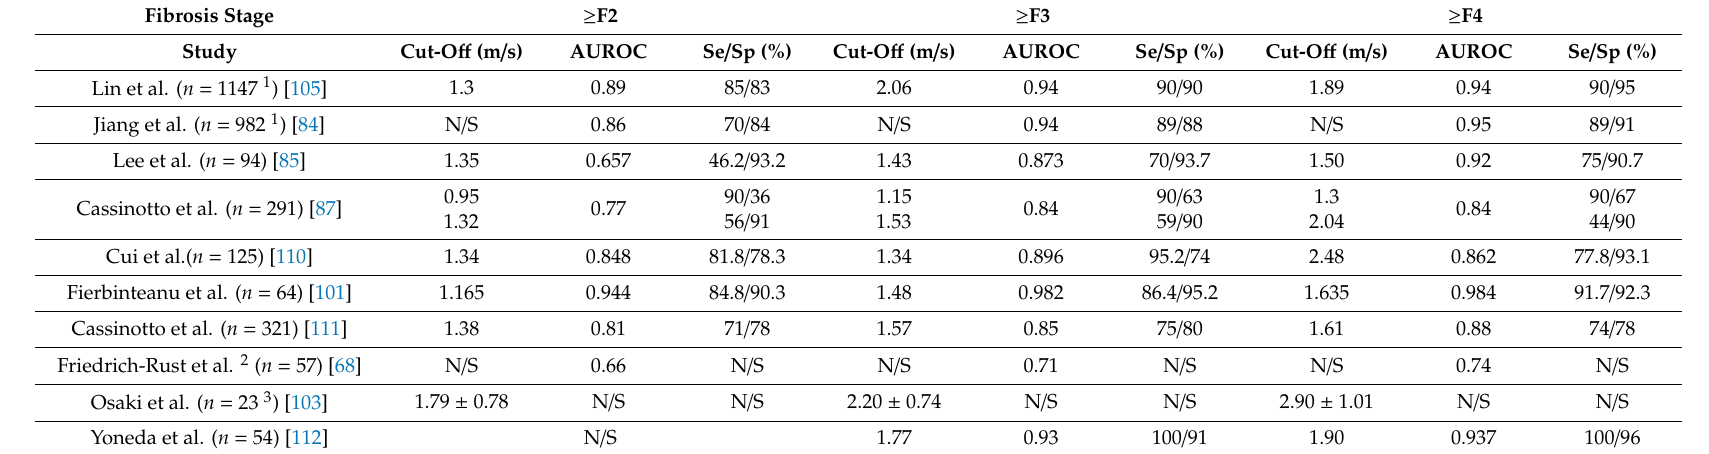
Table 3. Performance of ARFI for detecting di ff erent stages of liver fibrosis in NAFLD patients.